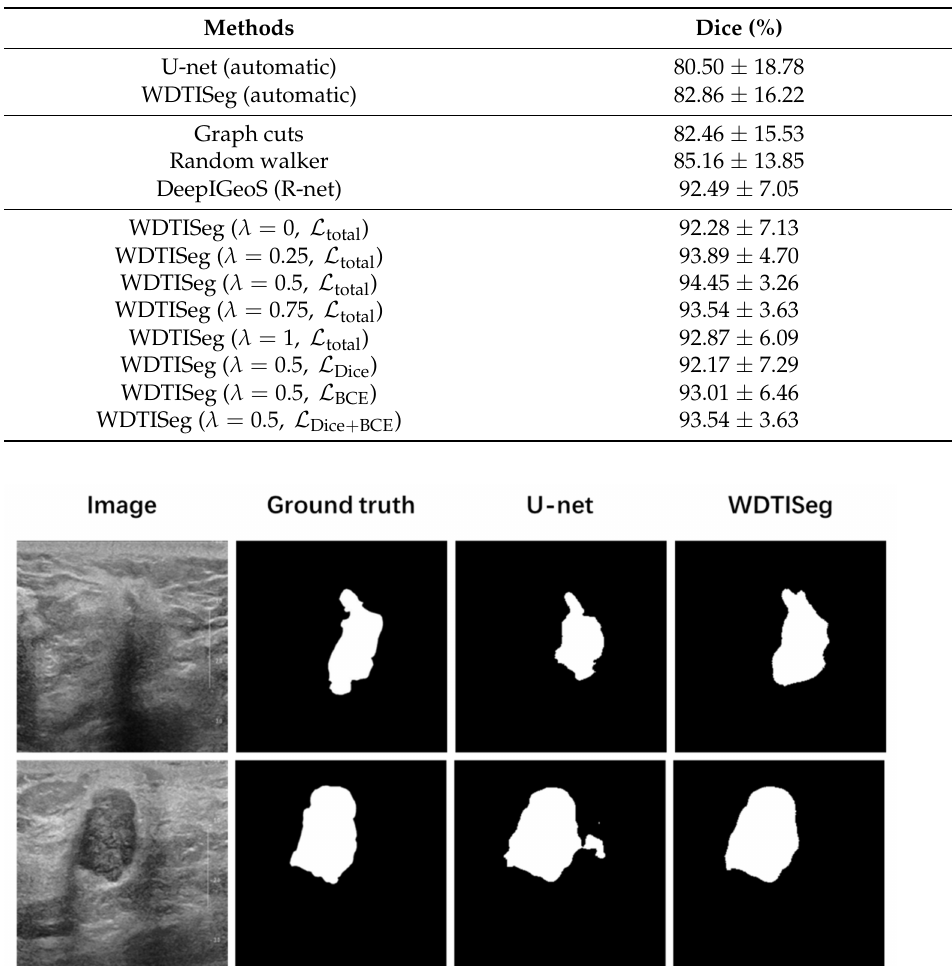
Table 1. A comparison of dice values of the final segmentation results after 8 interactions. Automatic segmentation results of U-net and WDTISeg are presented to reflect the gain of the interactive segmentation methods.